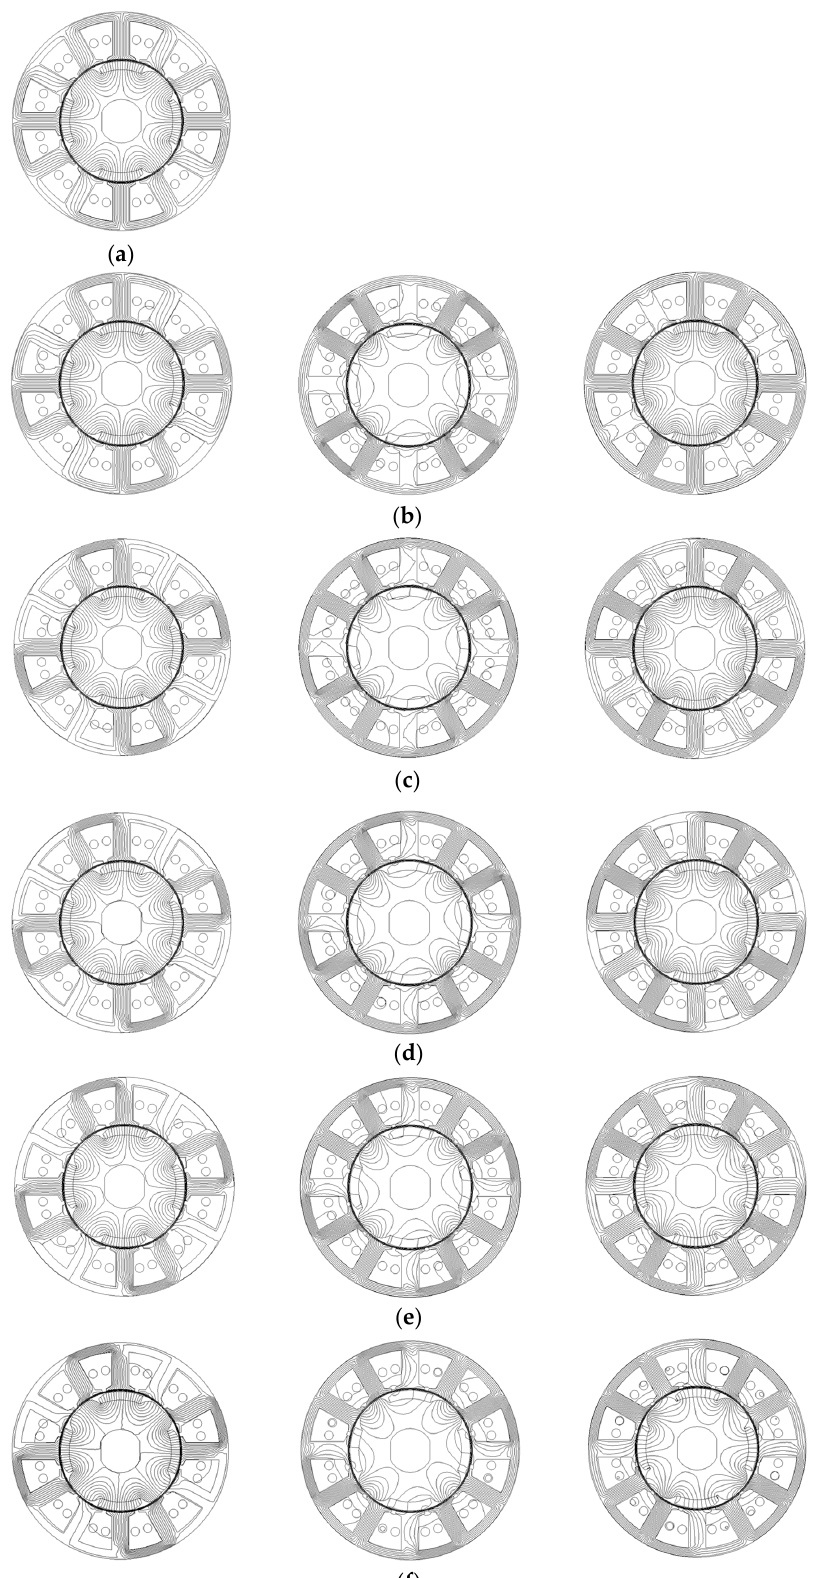
Figure 26. Flux densities and spectra of two PSCPPM machines. ( a ) 12s8p-PSCPPM. ( b ) 12s10p- PSCPPM.